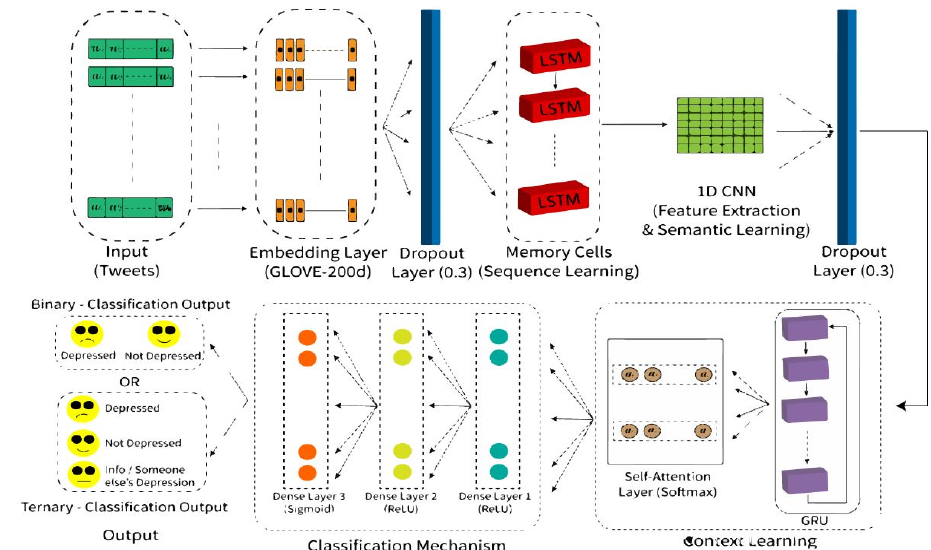
Figure 5. Architectural model of proposed